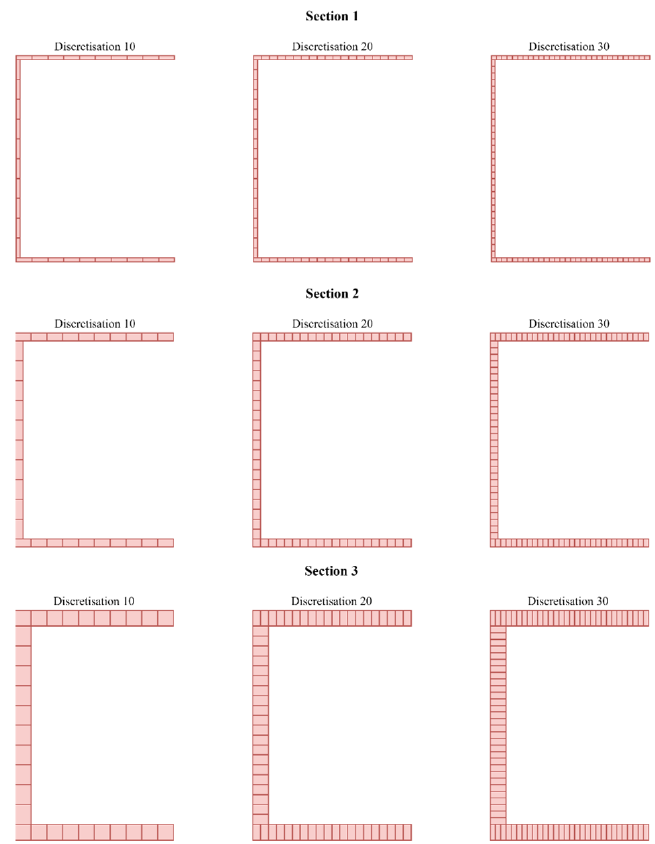
Figure 2. Selected C-shaped sections and their discretisation. Table 1. Geometrical properties of the selected